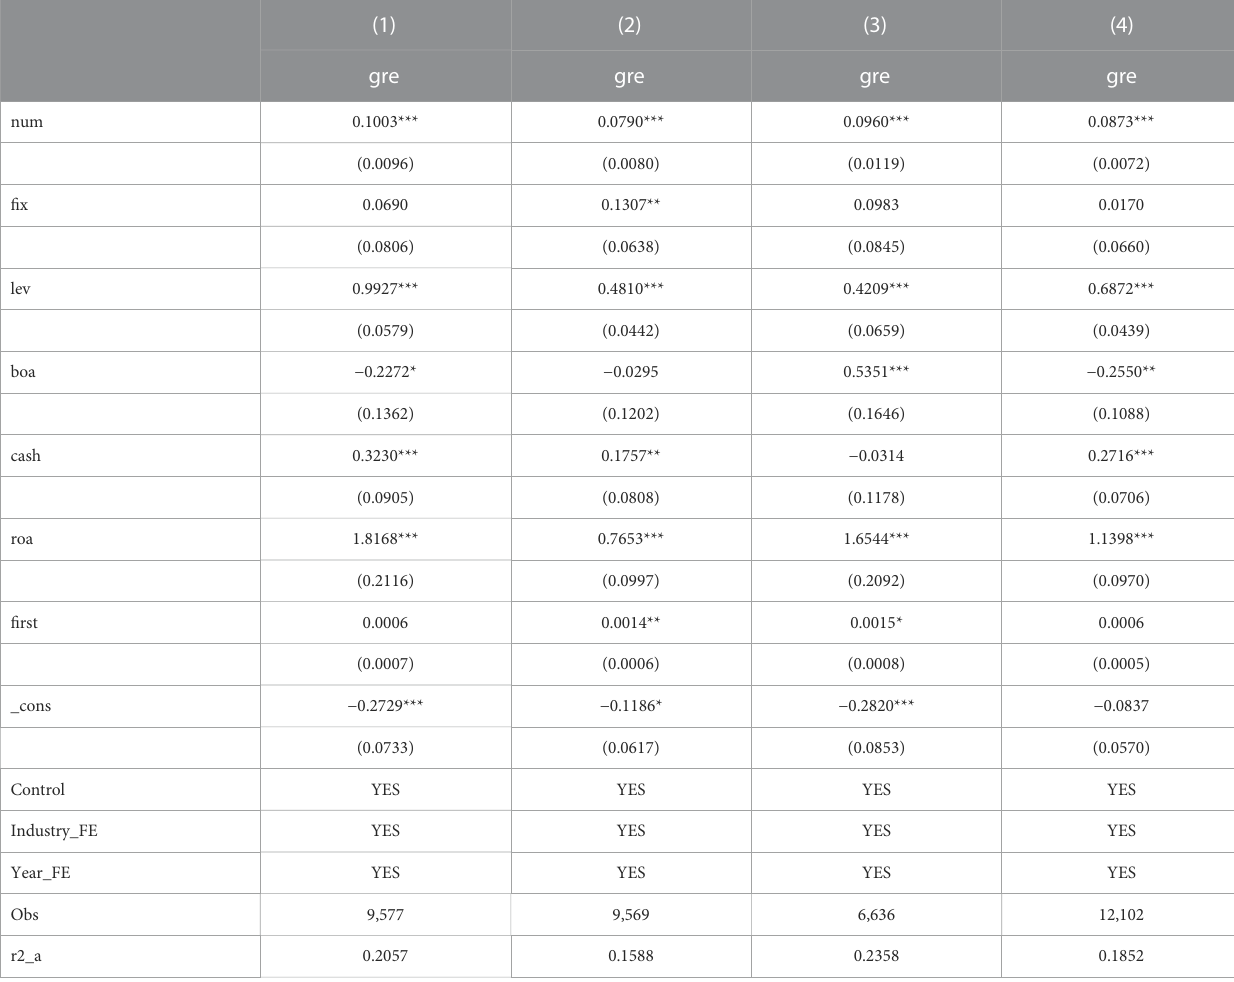
TABLE 7 Heterogeneity